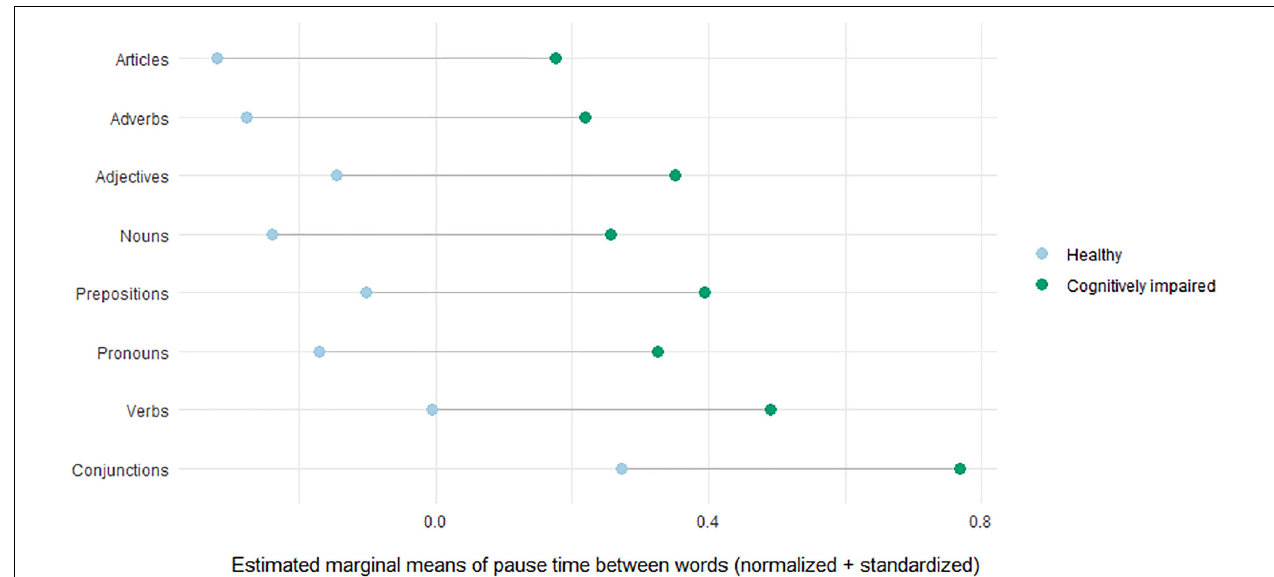
FIGURE 4 | Differences in estimated marginal means of healthy elderly and cognitively impaired patients for pause time between